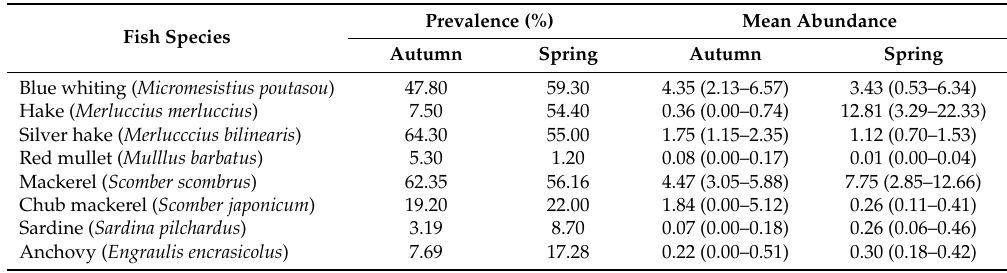
Table 4. Prevalence (%) and mean abundance and 95% confidence intervals of Anisakis type I larvae in the fish species analysed with respect to season of